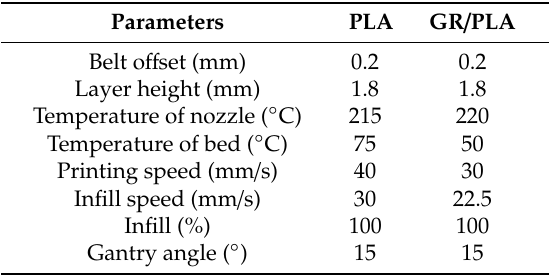
Table 1. Conveyor-fused deposition modeling (CFDM) 3D printing conditions used with polylactic acid (PLA) and graphene (GR)/PLA filaments in this study.